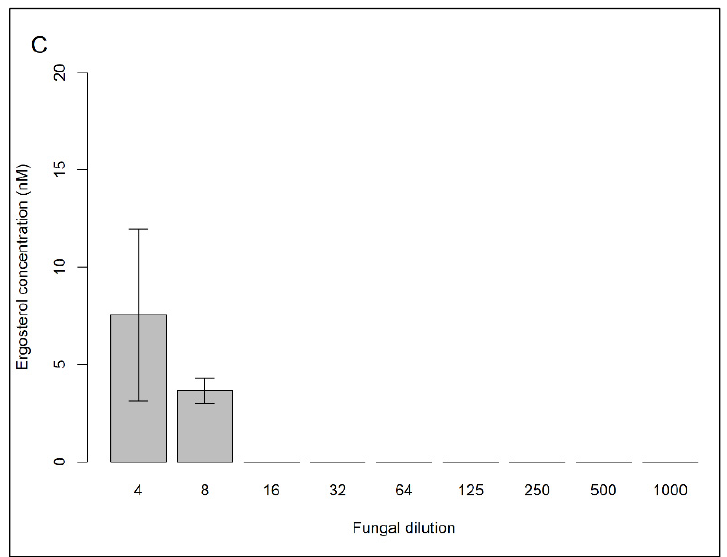
Figure 2. Ergosterol concentration in nM obtained with chloroform–methanol extraction from the marine fungal isolate Rhodotorula sphaerocarpa . Nine fungal dilutions in artificial seawater were used (4×, 8×, 16×, 32×, 64×, 125×, 250×, 500×, and 1000×). Extracts from the first ( A ), second ( B ), and third ( C ) extractions were analyzed.